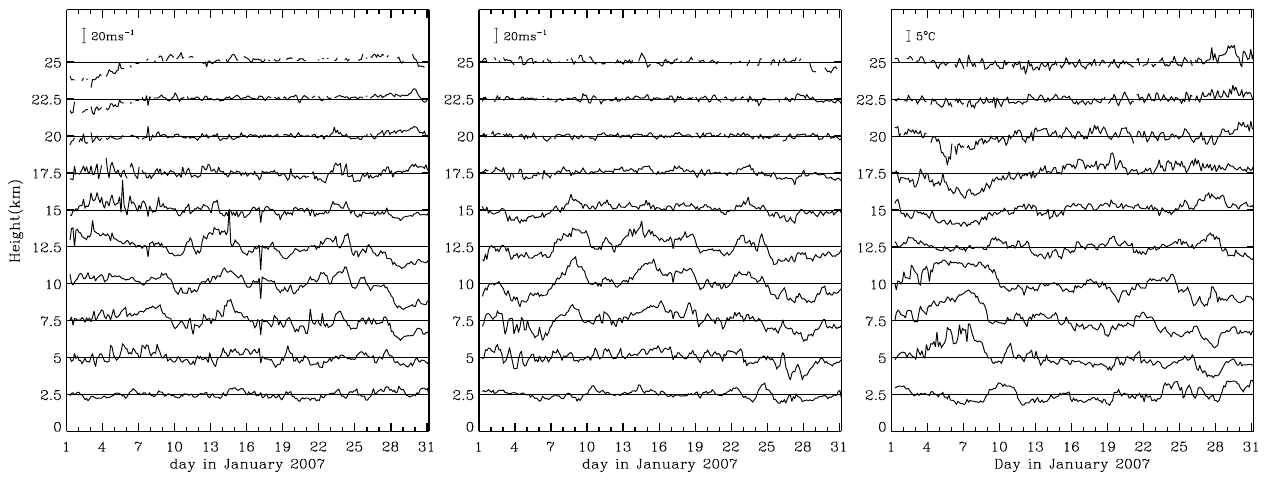
Fig. 2. Similar to Fig. 1, but in January